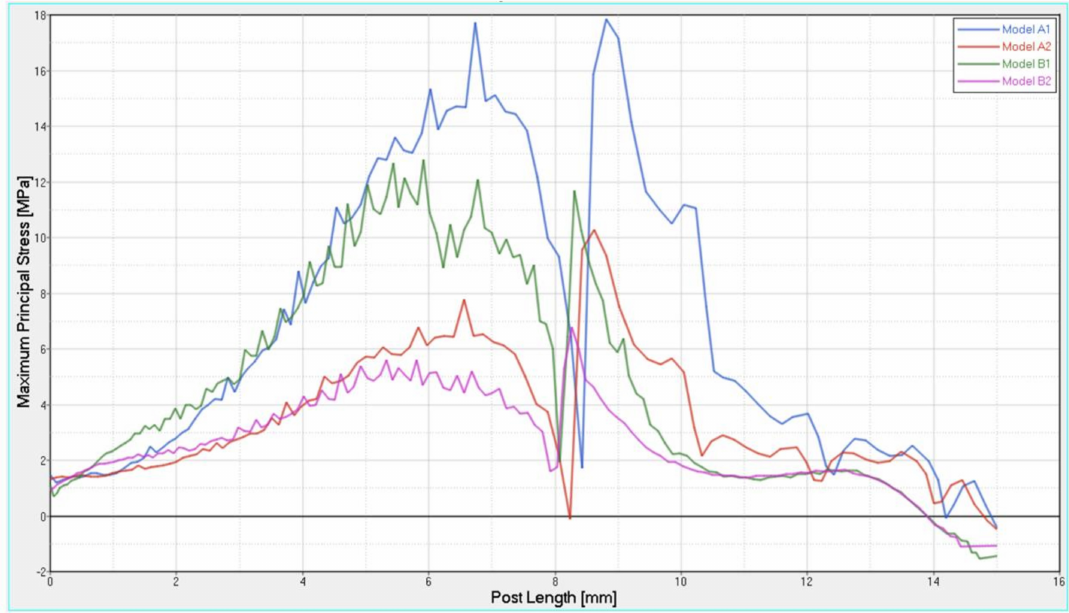
Figure 10. Models A1, A2, B1, and B2: Maximum principal stress distribution at the interface between the post and surrounding structures from the coronal to the apical